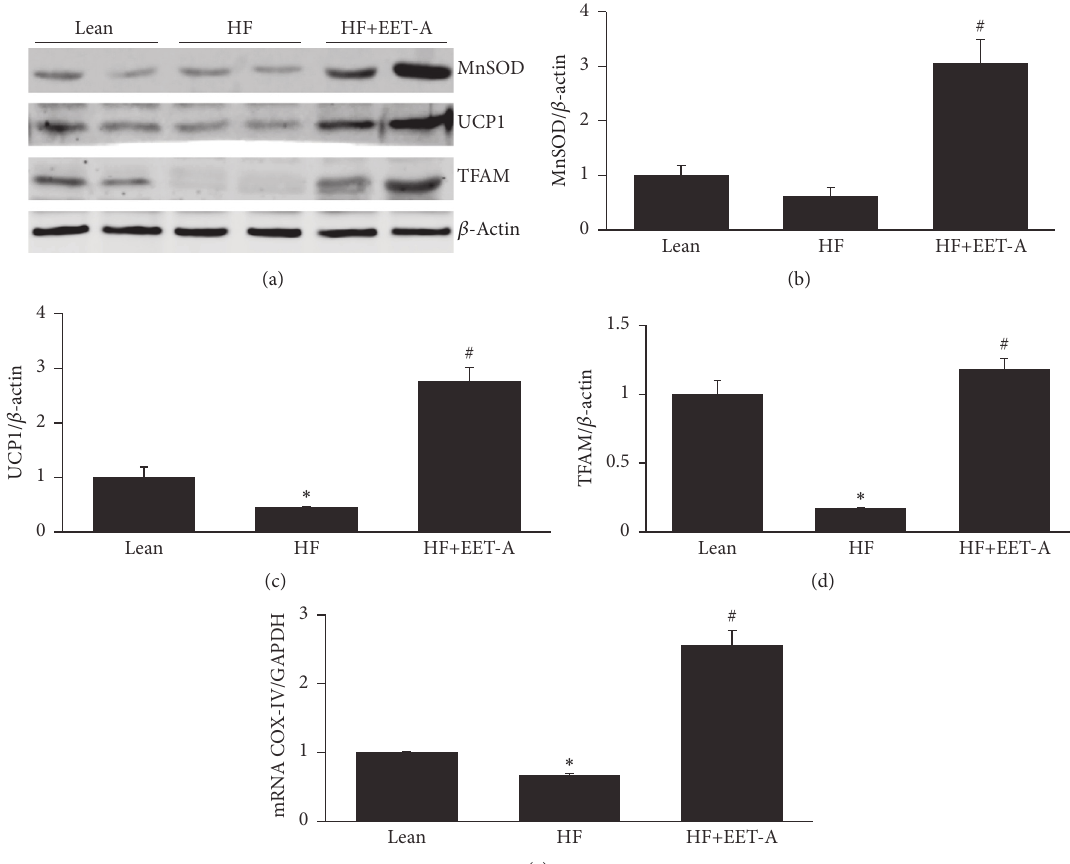
Figure 6: Effect of long-term EET-A treatment on the expression of genes involved in mitochondrial biogenesis and dynamics in adipose tissue of mice fed HF diet. Representative Western blots (a). Densitometry analysis of MnSOD (b), UCP1 (c), TFAM, (d) protein levels, and COX-IV mRNA levels (e) in adipose tissues of lean, HF diet fed (HF), and HF diet EET-A-treated (EET-A) mice. Results are mean ± SE, 𝑛 = 4 , ∗ 𝑝 < 0.05 versus lean, # 𝑝 < 0.05 versus